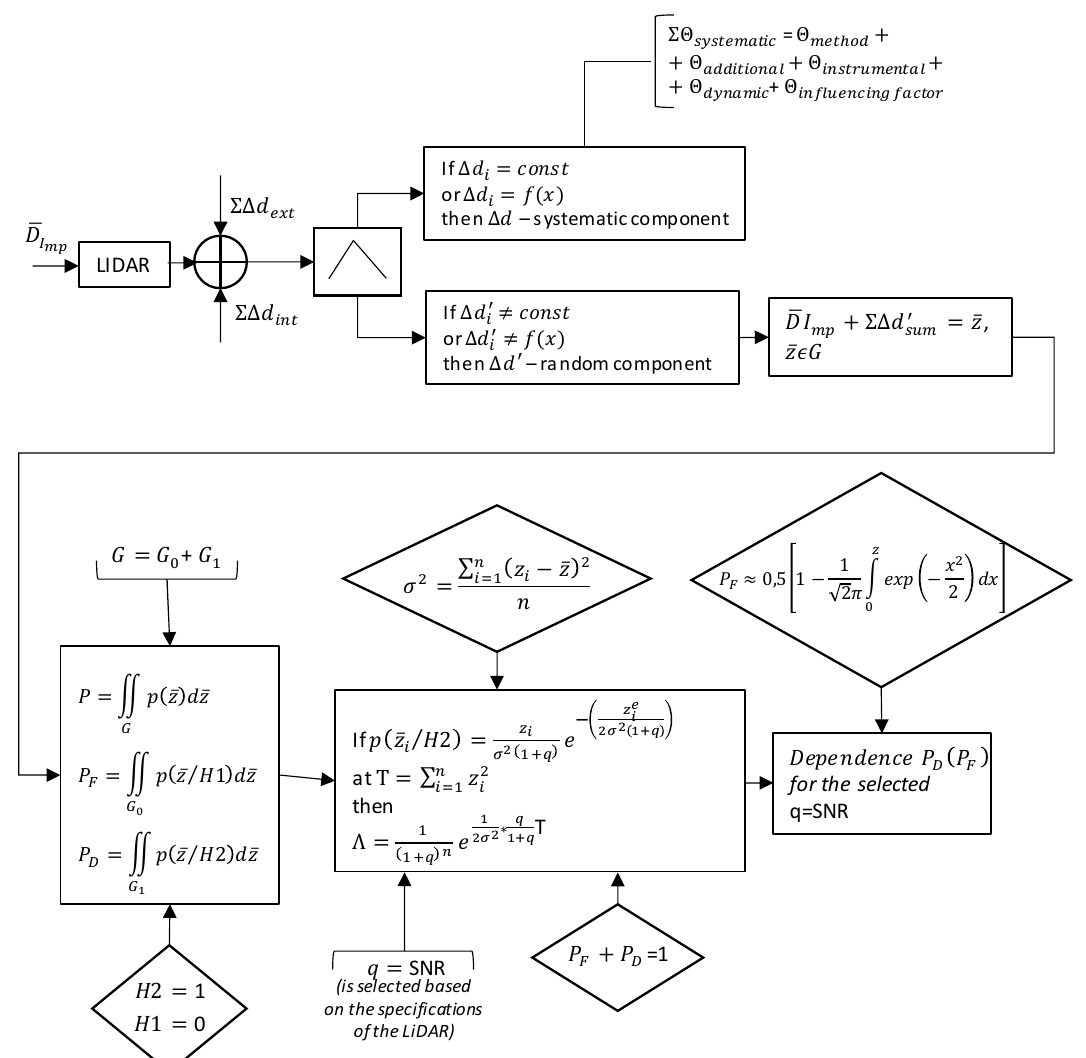
Figure 6. Flow chart of mathematical operations of the proposed approach.